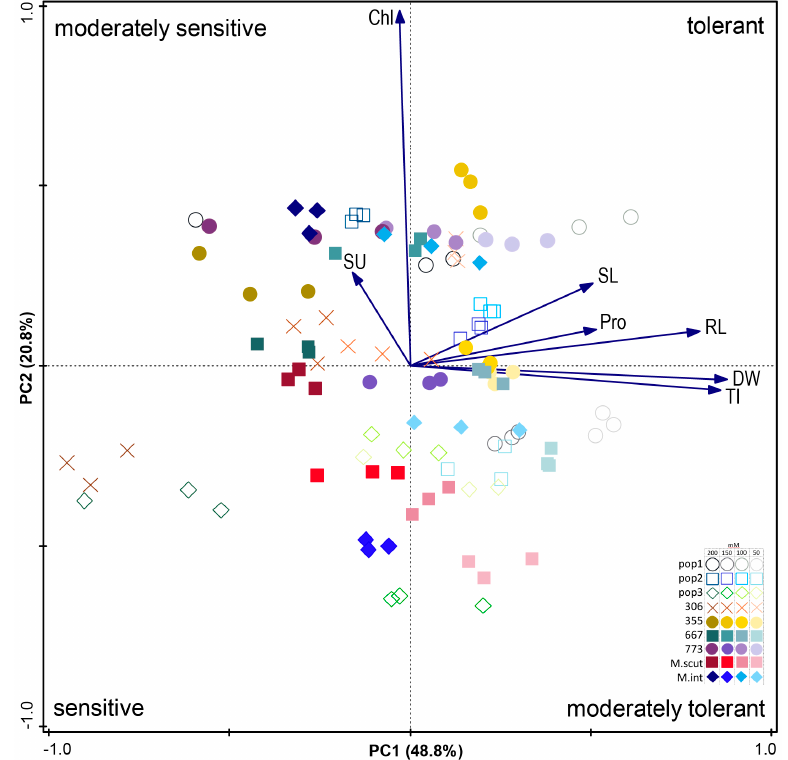
symbol that represents the type of population (table in graph). Chl—chlorophyll; SU—sugar; SL— epicotyl; Pro—proline; RL—radicle; DW—dry weight; TI—Tolerance Index. SL—epicotyl; Pro—proline; RL—radicle; DW—dry weight; TI—Tolerance